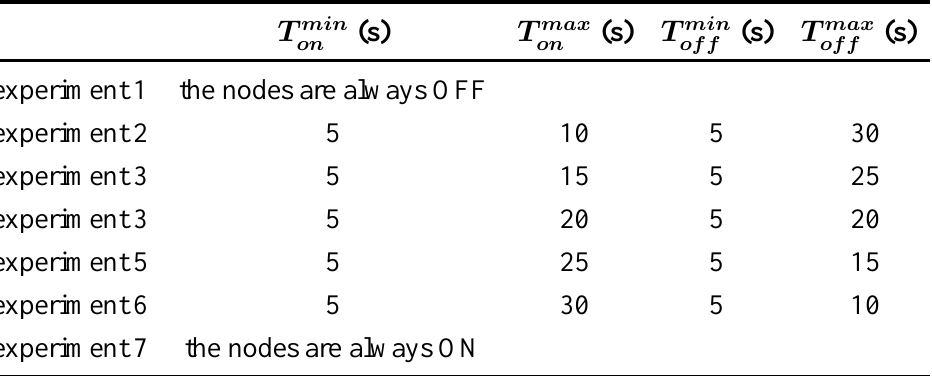
Table 1. Parameters used in each experiment.